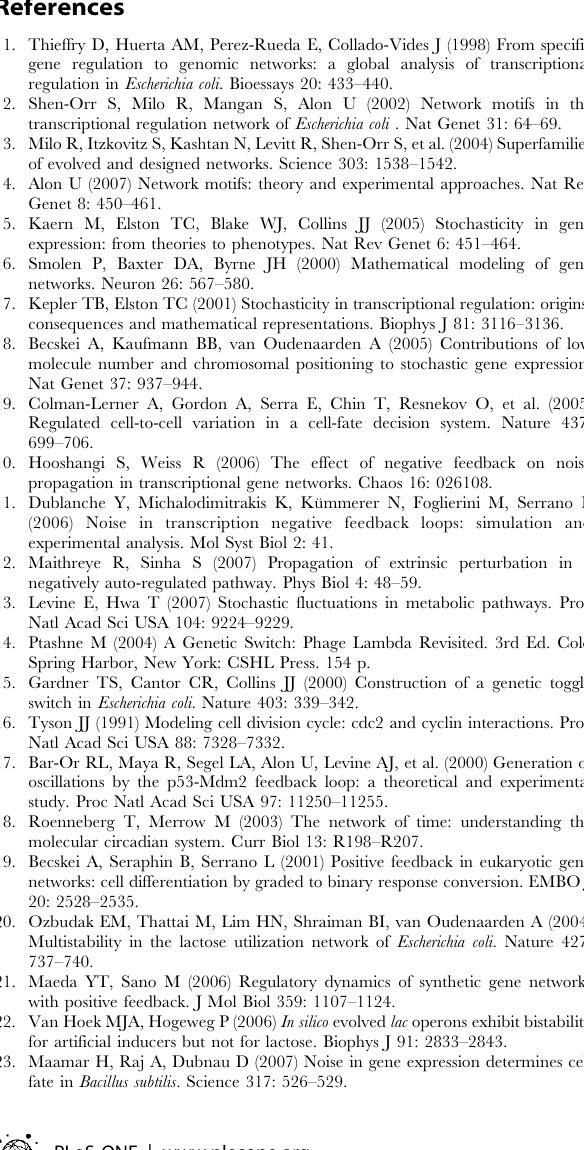
Table S2 Parameter values used for deterministic and